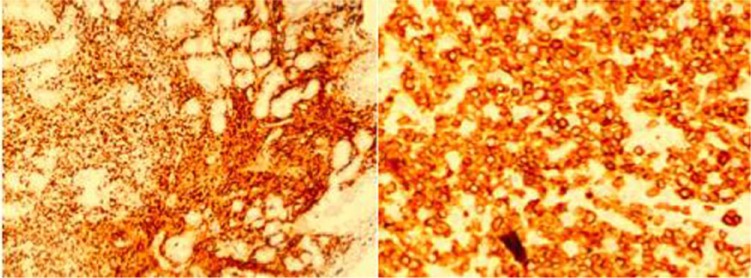
Right premaxillary mass immunohistochemistry: (a) Immunohistochemistry CD3+ MP ×10; (b) Immunohistochemistry CD3+ HP ×40.